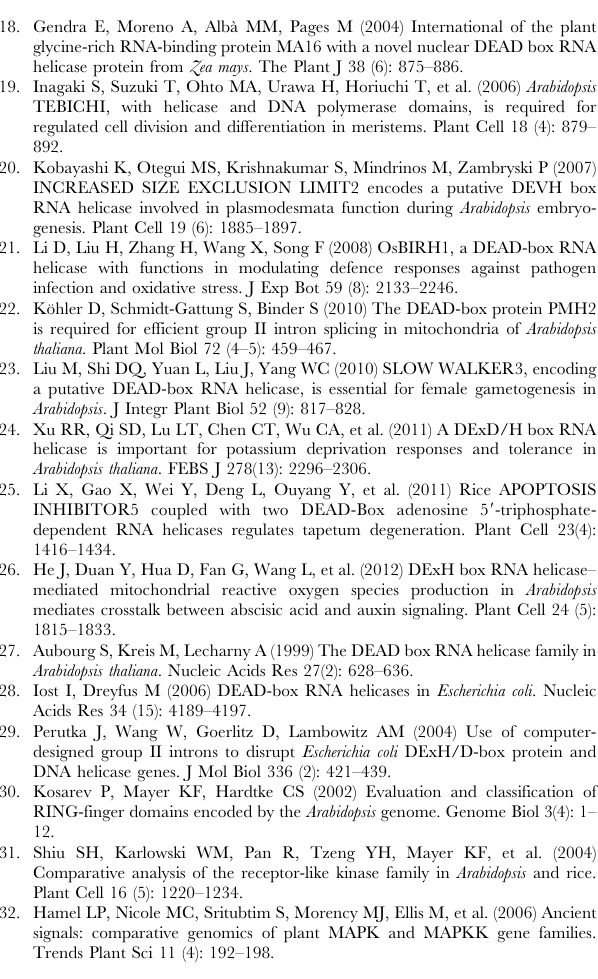
Figure S4 Phylogenetic tree analysis of RNA helicase in Glycine max . From left to right are the DEAD-box, DEAH-box and DExD/H-box RNA helicase proteins, respectively. The scale bar represents 0.2, 0.2 and 0.2 substitutions per sequence position, respectively. Sister pairs of paralogous helicase genes were indicated by red shadow, which had very strong bootstrap support ( . 90%). (TIF) Table S1 RNA helicase genes in Arabidopsis, Oryza sativa, Zea mays, Glycine max . Table S2 The primers used in the Real-time quantifi- cation RT-PCR